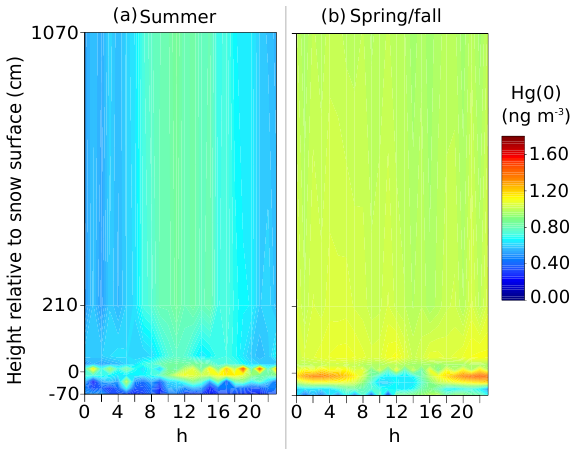
Figure 12. Hourly (local time) mean atmospheric and interstitial air Hg(0) concentrations in (a) summer, and (b) spring/fall. The verti- cal axis is the height of measurement relative to the snow surface (in cm). Color contours show Hg(0) concentrations (in ngm − 3 ). Con- centrations at 25, 210, and 1070cm above the snow surface were acquired on the meteorological tower while concentrations at 50, 10, − 10, − 30, − 50, and − 70cm were collected on snow tower #1. Data were cubic spline interpolated using software